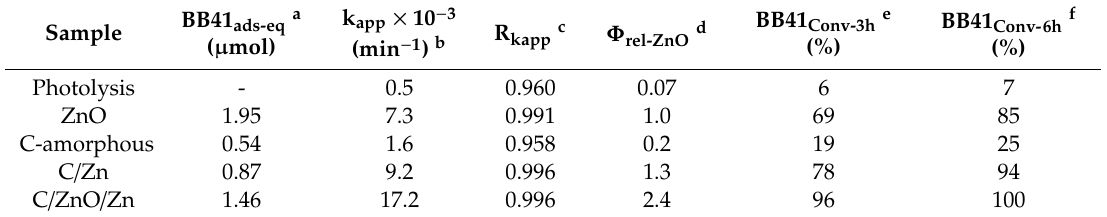
Table 4. List of kinetic parameters for the BB41 adsorption in the dark and photocatalytic degradation under solar irradiation.